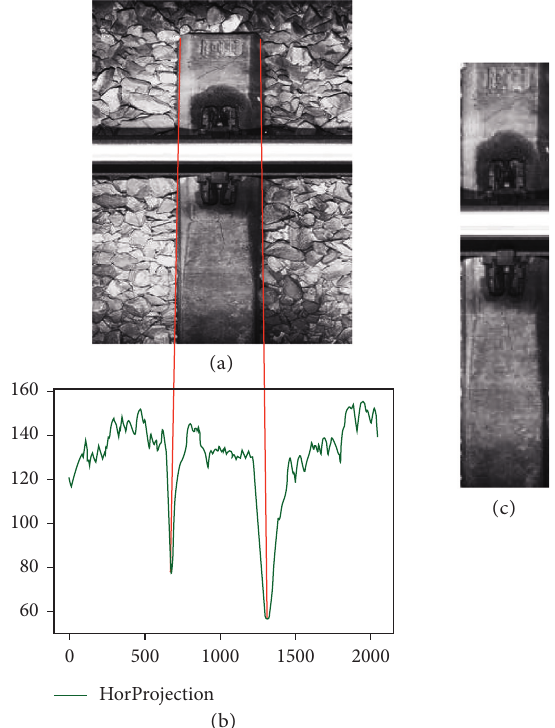
Figure 3: Gray projection experimental results. (a) Original image. (b) Horizontal projection. (c) Segmentation